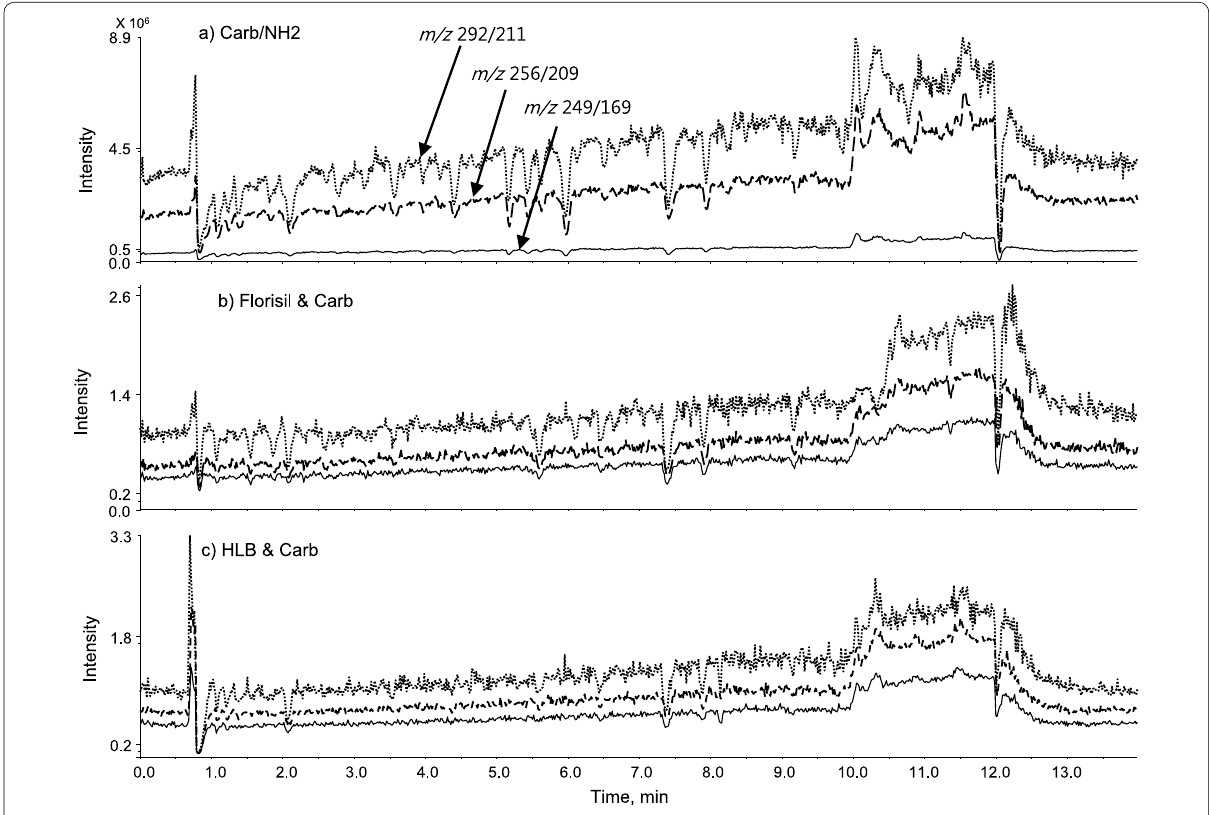
Fig. 1 Post-column infusion profiles of imidacloprid ( ‑ ‑ ‑ ‑ dashed line for m/z 256 thiamethoxam ( ……… dotted line for m/z 292 cartridge, b Florisil and Carb SPE cartridges, and c HLB and Carb SPE